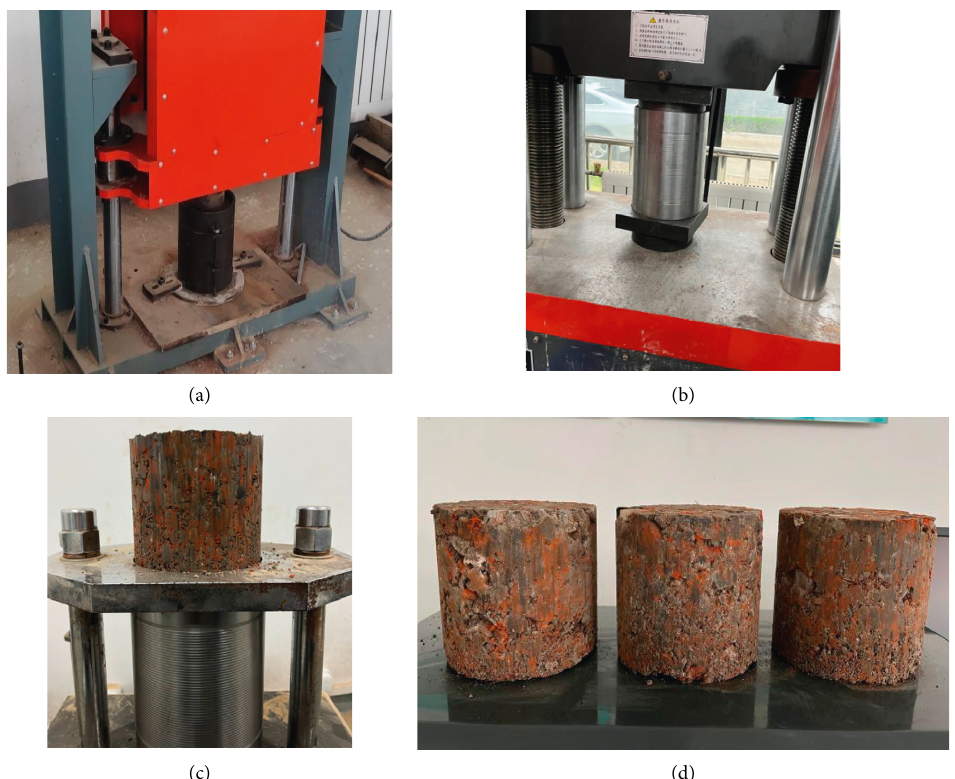
Figure 10: Specimen preparation. (a)Vibratory compaction, (b)static pressure, (c) specimen demolding, and (d) specimen after demoulding.